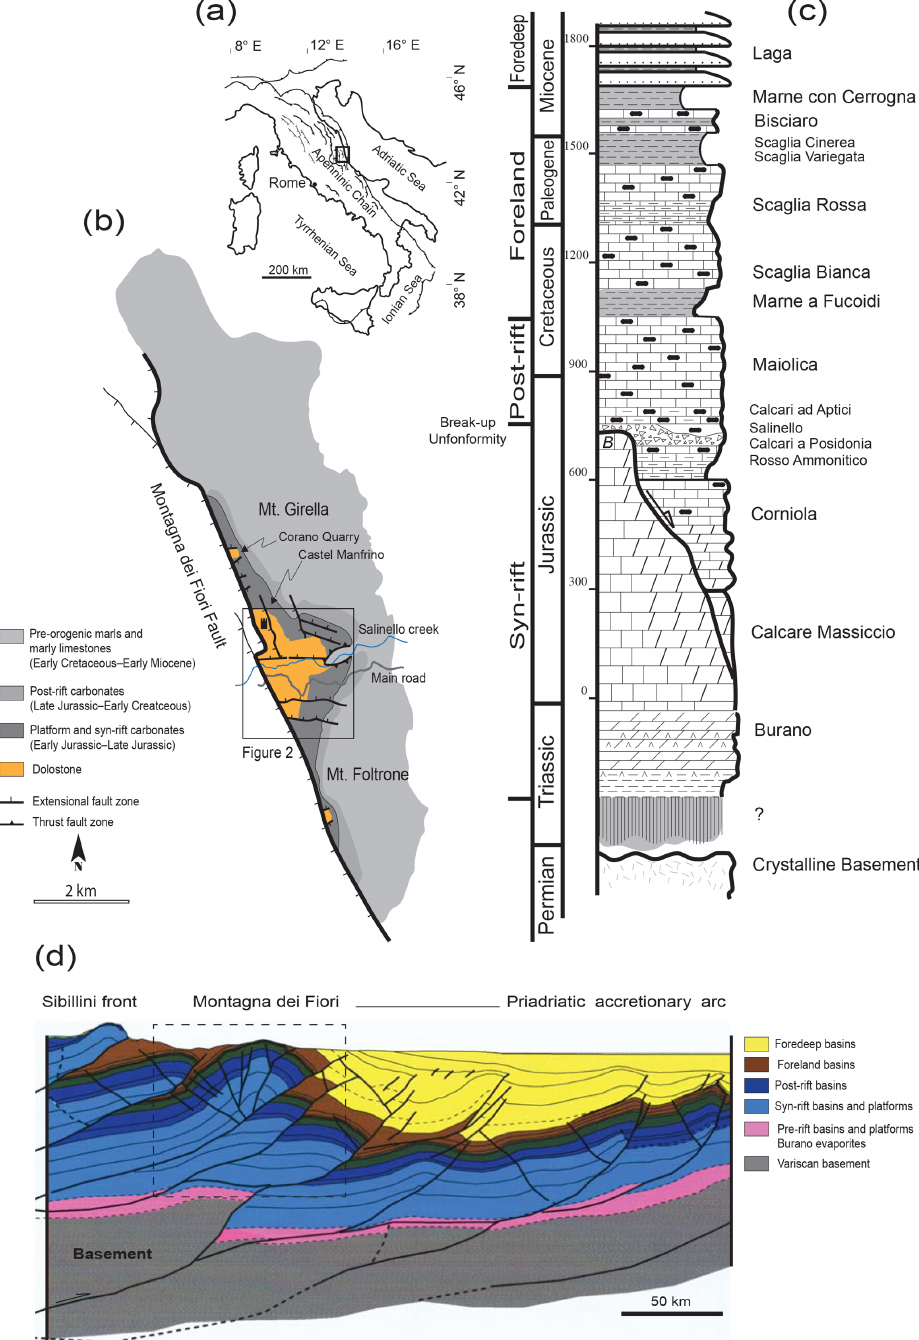
Figure 1. (a) Simplified regional map (modified after Ghisetti and Vezzani, 1997) showing the tectonic outlines of the Central Apennines and the study area (rectangle). (b) Schematic geological map of the Montagna dei Fiori Anticline showing the distribution of dolostones (modified after Storti et al., 2017a). (c) Lithostratigraphical column of the successions exposed in Montagna dei Fiori (modified after Mattei, 1987; Di Francesco et al., 2010; Storti et al., 2018). Letter B stands for the Bugarone Formation. Lithologies are mentioned in the text. Note that the thickness of the non-outcropping formations (Triassic evaporites and the crystalline basement) is not to scale. (d) Regional geological transect across present-day Central Apennines and the Adriatic Sea (modified after Fantoni and Franciosi, 2010) with vertical exaggeration of 2 : 1. The dashed rectangle indicates the Montagna dei Fiori Anticline region.